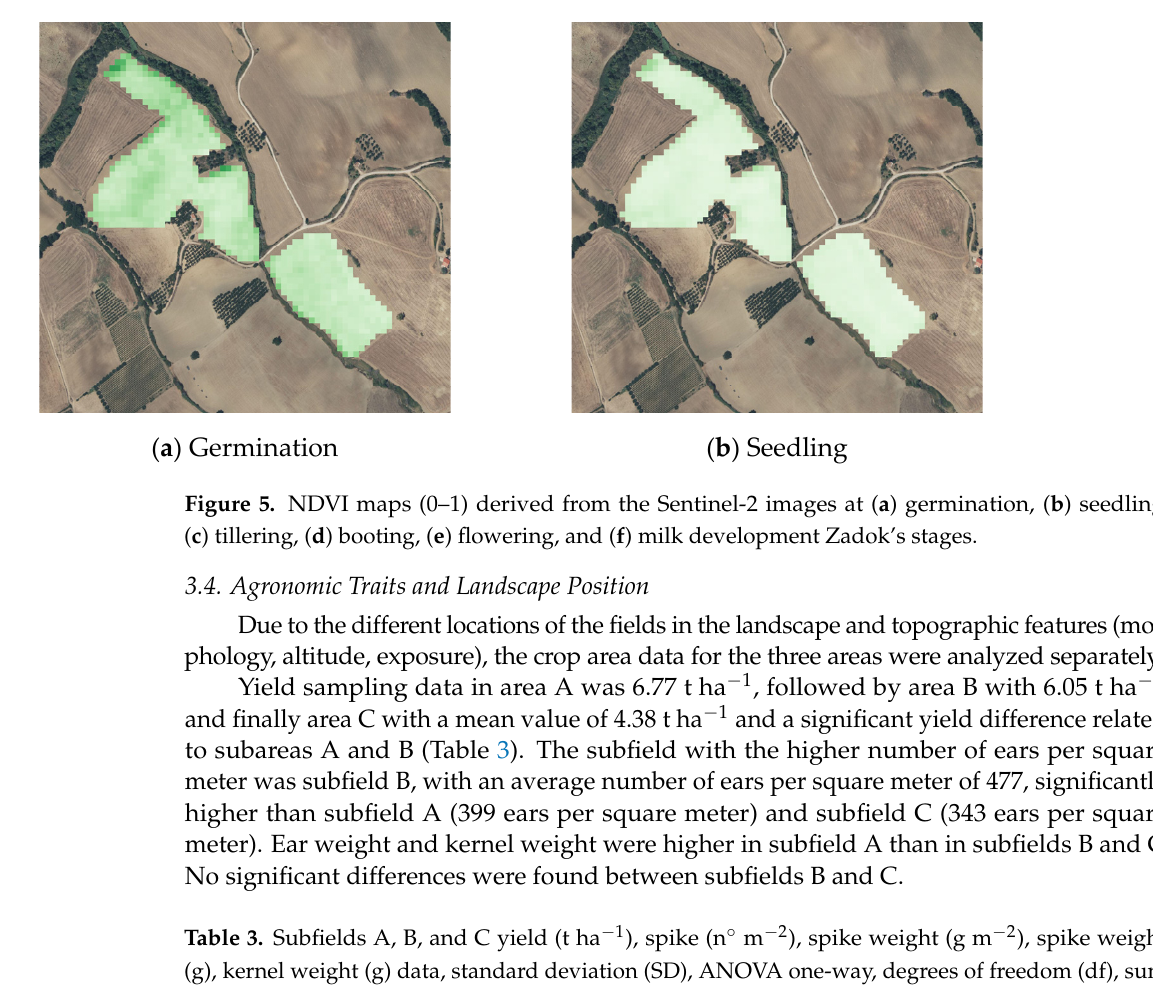
No significant differences were found between subfields B and C. Table 3. Subfields A, B, and C yield (t ha − 1 ), spike (n ◦ m − 2 ), spike weight (g m − 2 ), spike weight (g), kernel weight (g) data, standard deviation (SD), ANOVA one-way, degrees of freedom (df), sum of square (SS), mean square (MS), F-value, and p -value. For each mean effect, values in a column followed by the same letter are not significantly different at p ≤ 0.05, different letter are significantly different at p ≤ 0.05 as determined by the Fisher test.